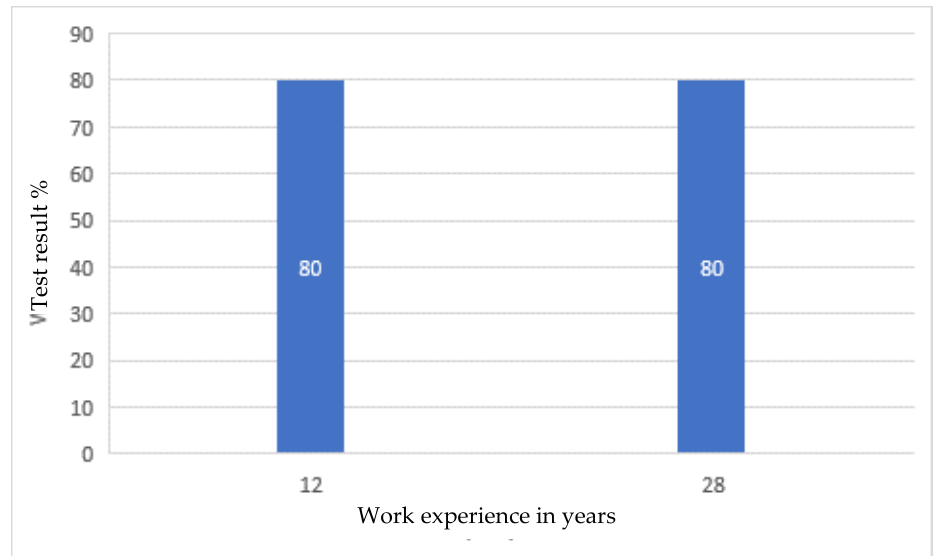
Figure 3. Research results regarding repair and maintenance of the conveyor belt, depending on professional experience.